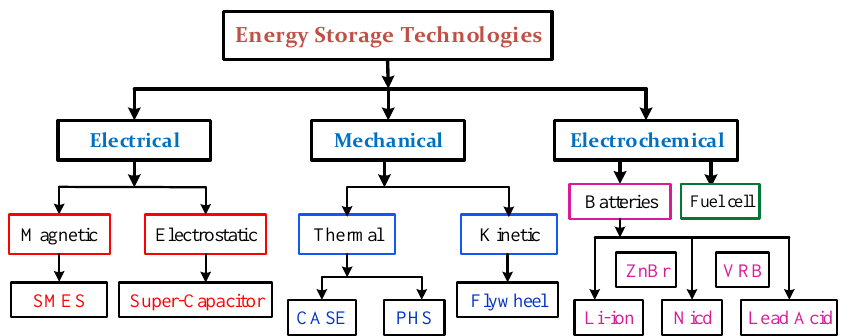
Figure 3. Classification of common forms of energy storage used in renewable energy.